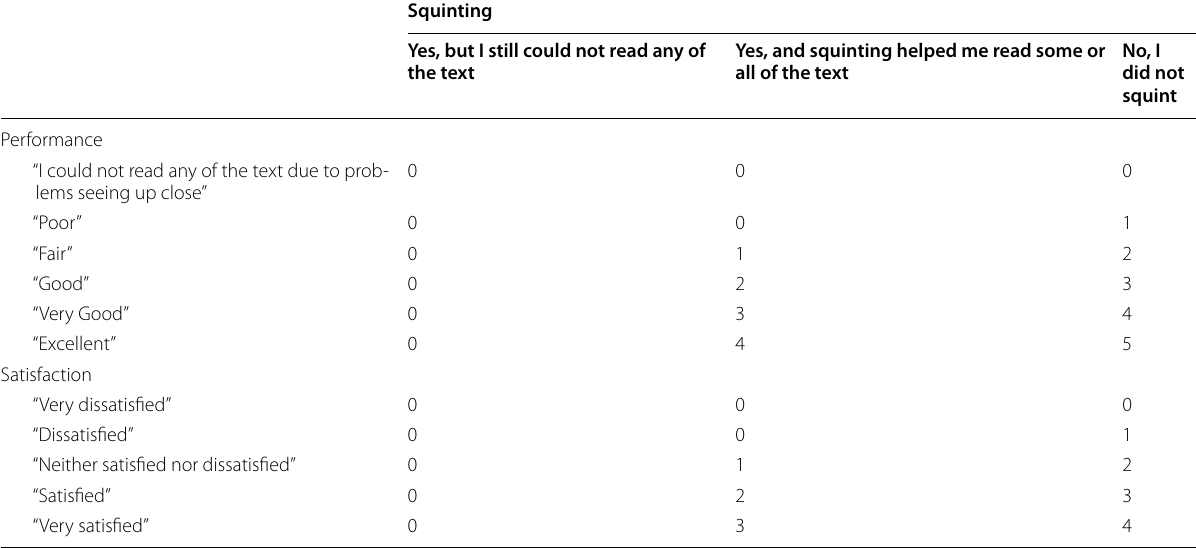
Table 5 Testlets variables for Performance